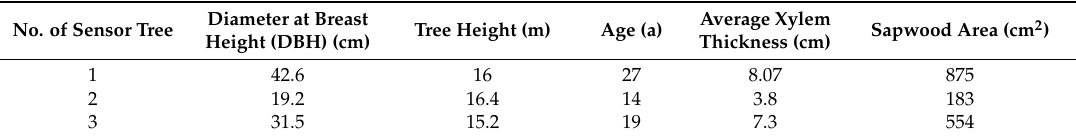
Table 2. Data of the three sensor